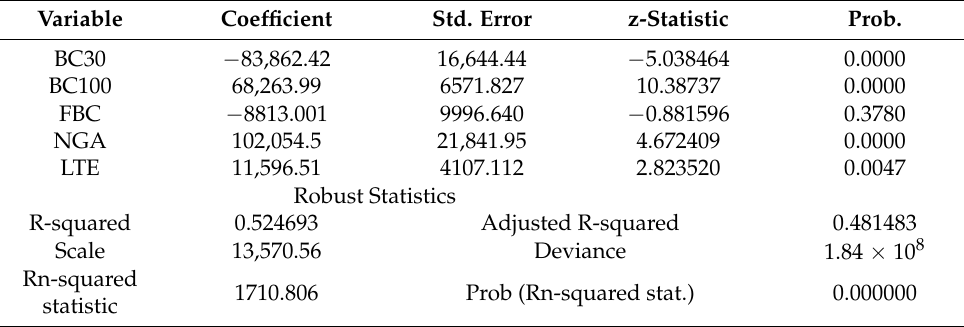
Table 6. Robust least squares regression results for the dependent variable